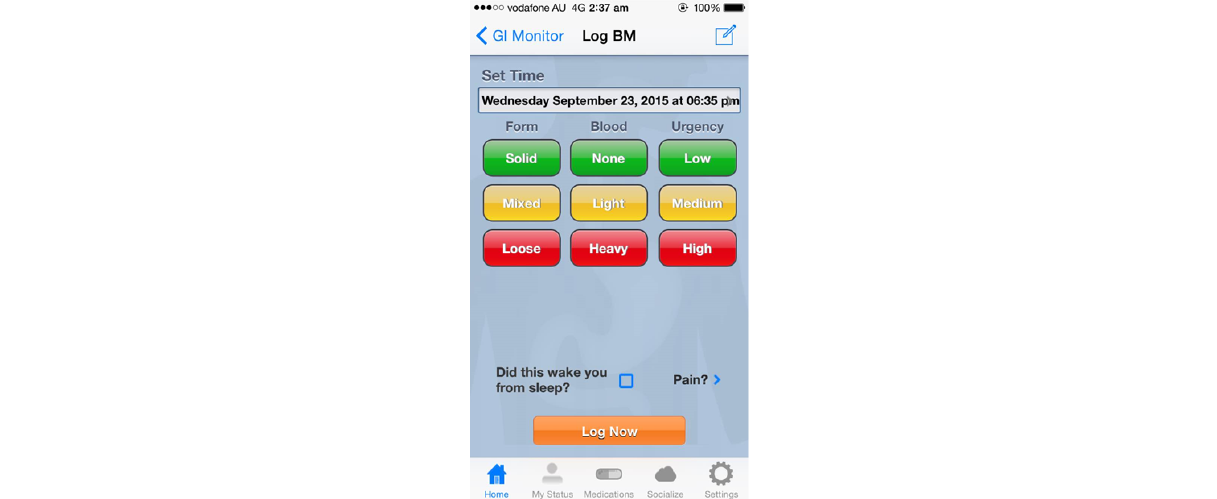
Figure 3. Screenshot of the interface of GI Monitor for recording bowel